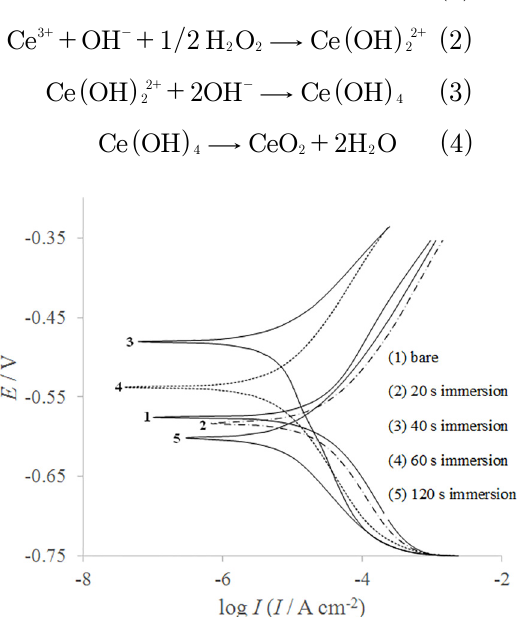
Figure 1. Potentiodynamic polarization curves of cerium-coated steel in 3.5 wt% NaCl solution. Conversion coatings were obtained at 25 °C in cerium solution with different immersion times: (1) bare, (2) 20 s, (3) 40 s, (4) 60 s and (5) 120